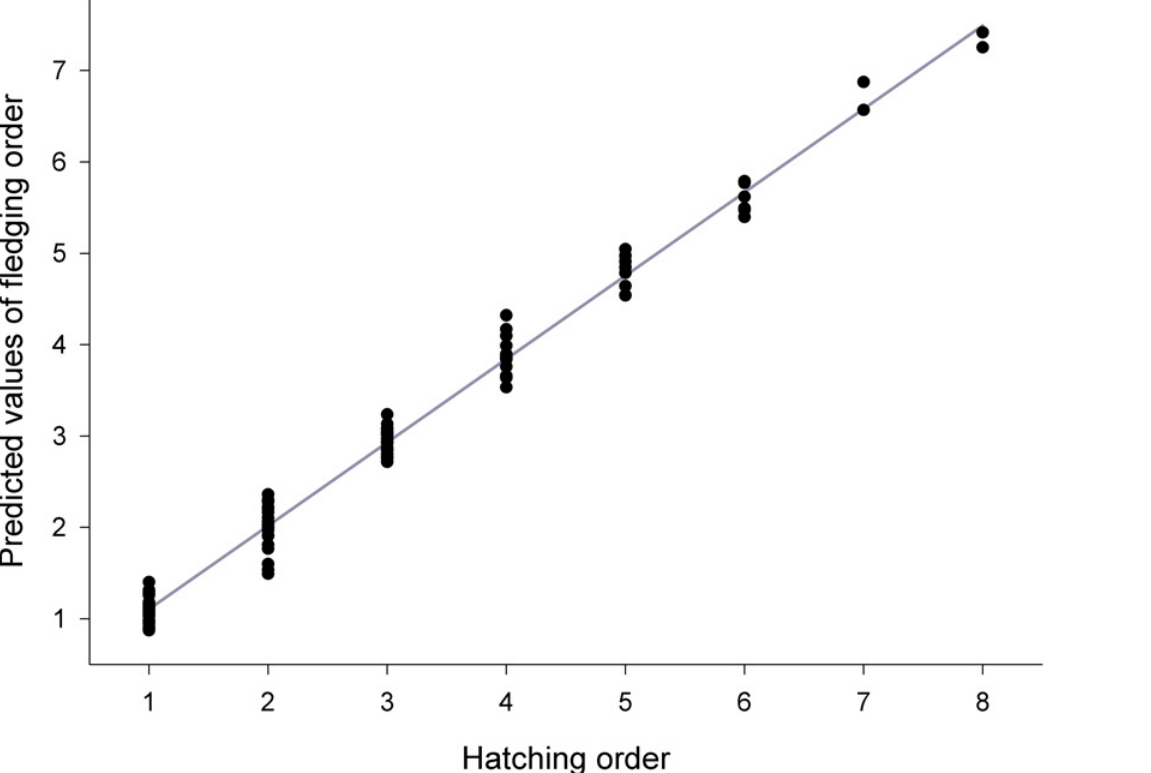
Fig 2. Predicted values of the fledging order plotted against the order of hatching within individual